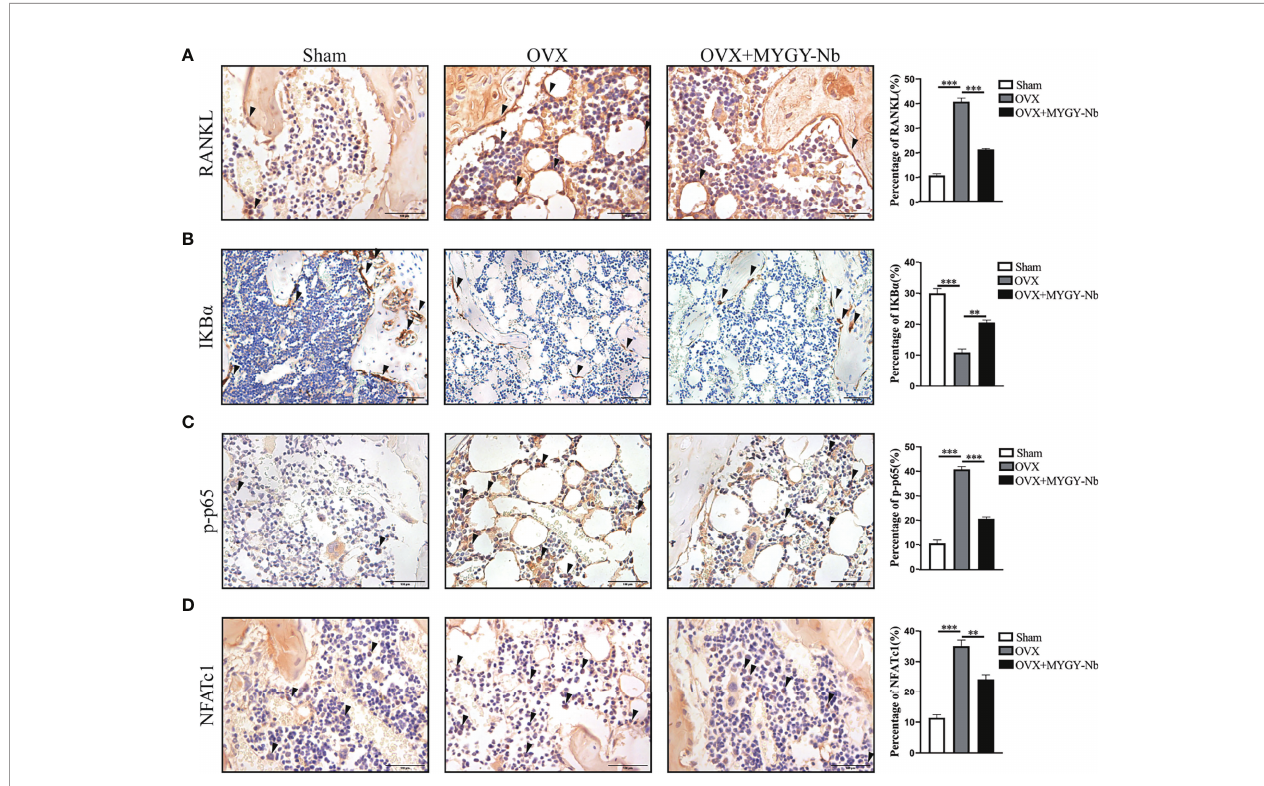
FIGURE 5 | MYGY-Nb inhibited osteoclast formation by suppressing the RANKL-mediated NF- k B pathway in OVX mice. Representative IHC images and quanti fi cations of RANKL (A) , IKB a (B) , p-p65 (C) and NFATc1 (D) . Scale bars: 100 m m. Data were presented as means ± S.D. ** P < 0.01; *** P < 0.001. n = 6 in each group.